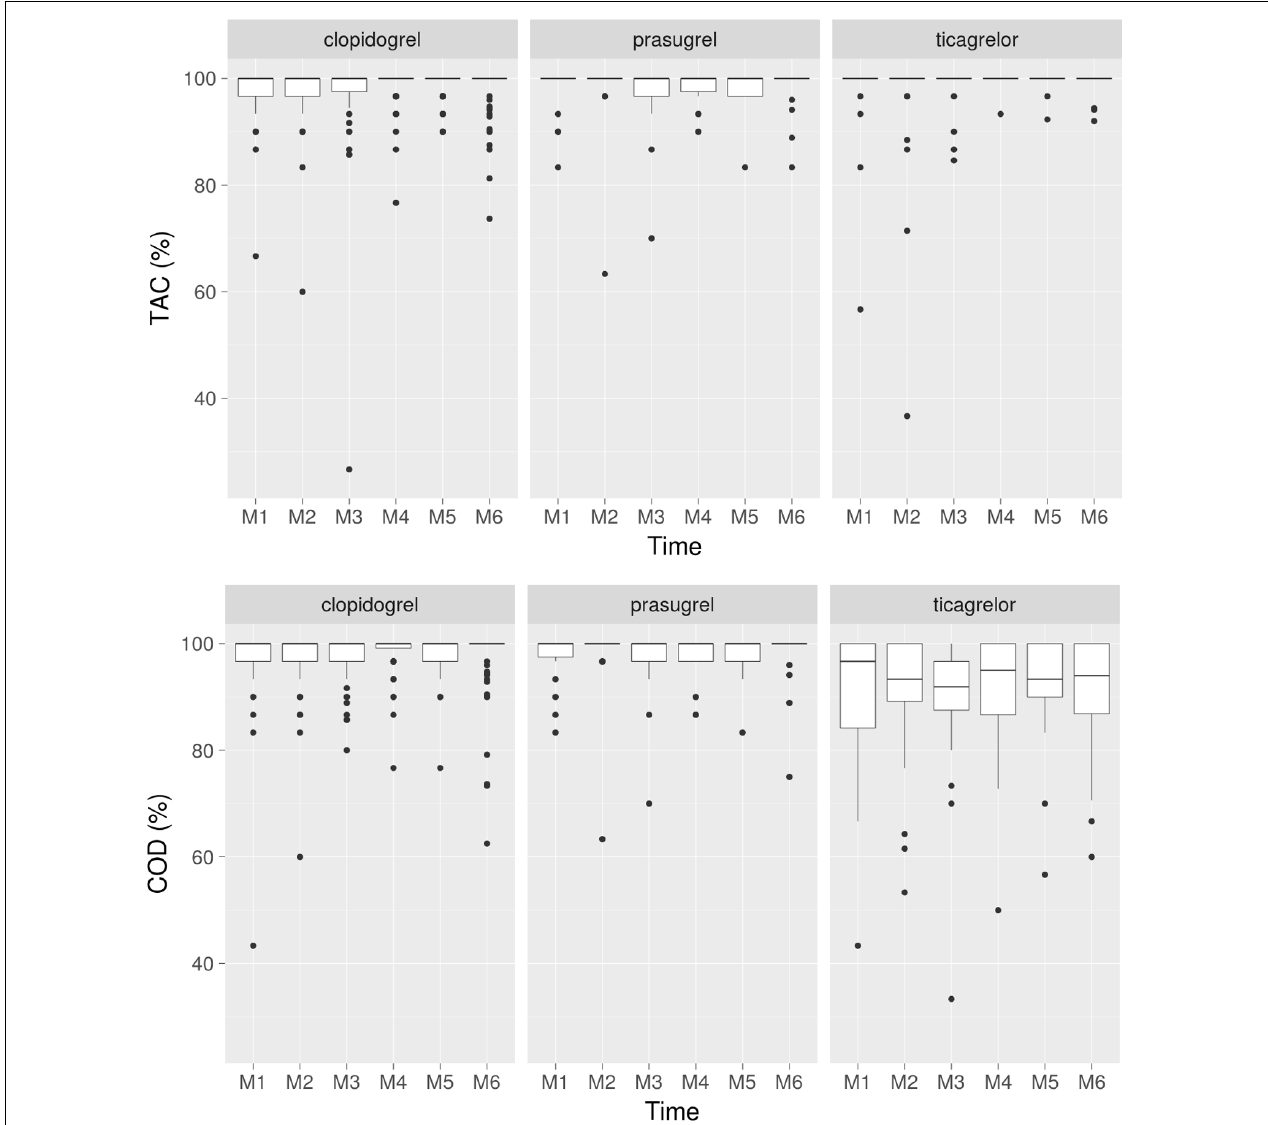
FIGURE 3 | Taking adherence (upper) and correct adherence (lower) over the 6-months monitoring period according to the anti-P2Y12 drug. Correct adherence ( Cod ), proportion of days with correct dosing during the time window; Taking adherence ( Tac ), proportion of prescribed drug taken during the time